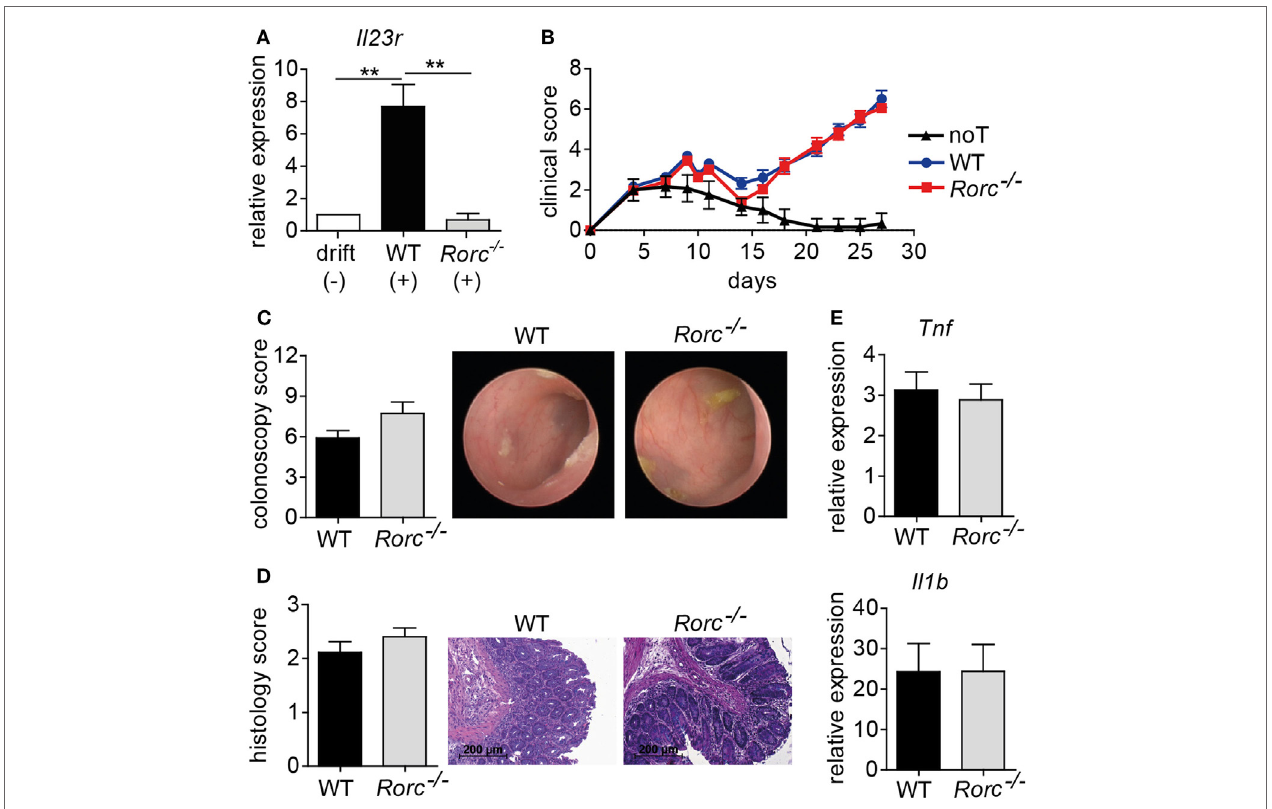
FigUre 2 | Retinoic acid-related orphan receptor gamma t (ROR γ t)-dependent T helper (Th17) cells are dispensable for acute intestinal graft-versus-host disease (GvHD). (a) Naïve CD4 + T cells were isolated from the spleen by negative selection using magnetic microbeads and in vitro polarized into inflammatory Th17 cells by co-culturing anti-CD3/anti-CD28 activated T cells in the presence of anti-IFN γ antibodies and either without ( − ) or with ( + ) recombinant interleukin (IL)-1 β , IL-6, and IL-23. After 5 days, T cells were harvested, RNA was isolated, and transcribed into cDNA followed by quantitative real-time PCR (qPCR) analyses of Il23r transcript levels. Gene expression levels detected within T cells cultured under drift conditions were arbitrarily set down to 1 and all other gene expression levels were normalized to the expression level of this control. Data are combined from two individual experiments and were analyzed by one-way ANOVA followed by Bonferroni’s multiple comparisons posttest. ** p < 0.01 was considered significant. Data are shown as mean ± SEM. (B–e) For GvHD induction, BALB/c mice were irradiated (day 0), transplanted with T cell-depleted bone marrow (BM) (day 1) and subsequently injected with allogeneic splenic CD3 + T cells of wild-type (WT) ( n = 18) or Rorc − / − ( n = 23) mice (day 2). As a control, one group of mice received T cell-depleted BM alone [no T cells (noT); n = 6]. (B) Clinical symptoms of GvHD mice were scored three times a week. Pooled data from three independent experiments are shown and were analyzed by two-way ANOVA followed by Bonferroni’s multiple comparisons posttest. (c) Between day 28 and day 30, colonic inflammation of WT ( n = 12) or Rorc − / − ( n = 11) T cell receiving mice was assessed by colonoscopy and representative endoscopic images are shown. Mice were sacrificed the day after colonoscopy. (D) Histopathological scoring of the colitis activity within the distal colon of WT ( n = 9) or Rorc − / − ( n = 10) T cell receiving mice was performed. One representative hematoxylin and eosin-stained histological cross-section of the distal colon per group is shown. Scale bars: 200 µm. Shown results represent pooled data from two individual experiments. (e) Gene expression levels detected within colonic tissue of WT or Rorc − / − T cell receiving mice of Tnf (WT n = 16; Rorc − / − n = 12) and Il1b (WT n = 17; Rorc − / − n = 14) around day 30 were analyzed by qPCR. Data display pooled data from at least three individual experiments. Data were analyzed by Student’s t -test and are shown as mean ±